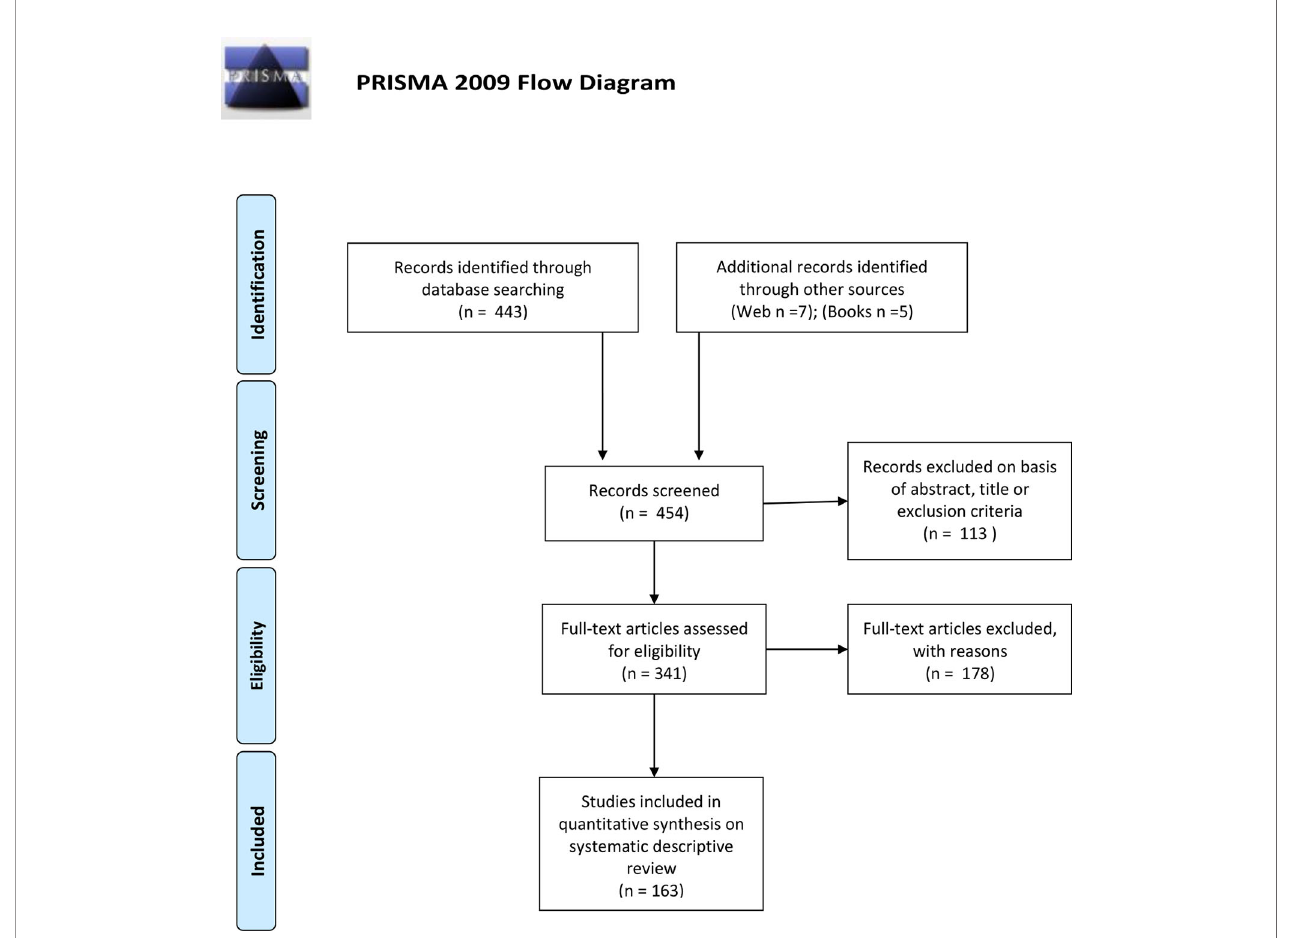
FIGURE 1 | PRISMA fl ow